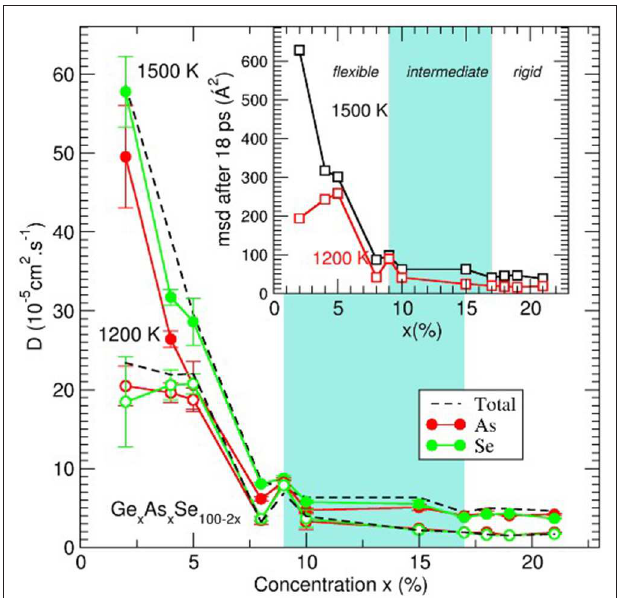
FIGURE 9 | Average self-diffusion constant (broken lines) and species dependent (As, red; Se, green) self-diffusion constant D(x) for two isotherms (1,500 and 1,200K) as a function of content x in Ge x As x Se 100 − 2x glass-forming liquids. The inset represents the Se average mean-square displacement after 18 ps simulation time. Gray zones represent the location of the intermediate phase.